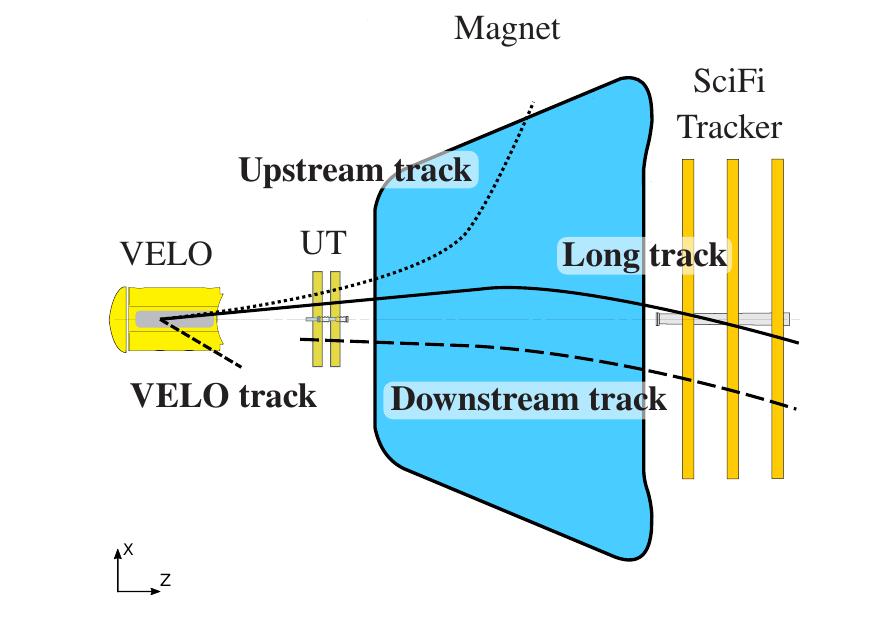
Figure 1. UT tracking subdetectors and tracks